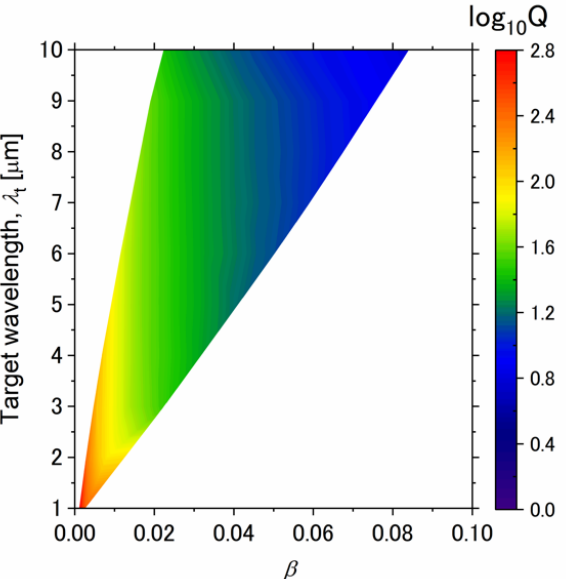
Figure 3. Quality factor for different target wavelengths, and bandwidth parameter β . Normal emissivity is calculated from the equivalent circuit model to obtain the quality factor. Table 1. Design parameters and obtained quality factors of the graphene ribbon metasurface.